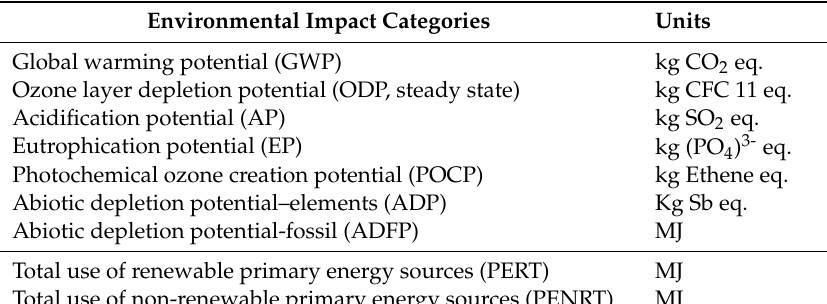
Table 2. Basic environmental impact categories used for